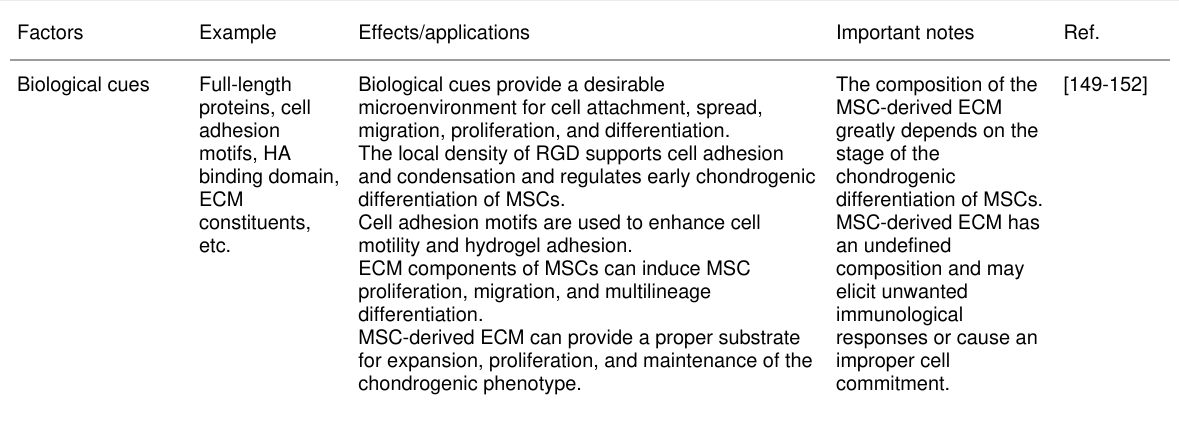
Table 2: Summary of the factors influencing cell fate that should be taken into account when designing a scaffold. Factors